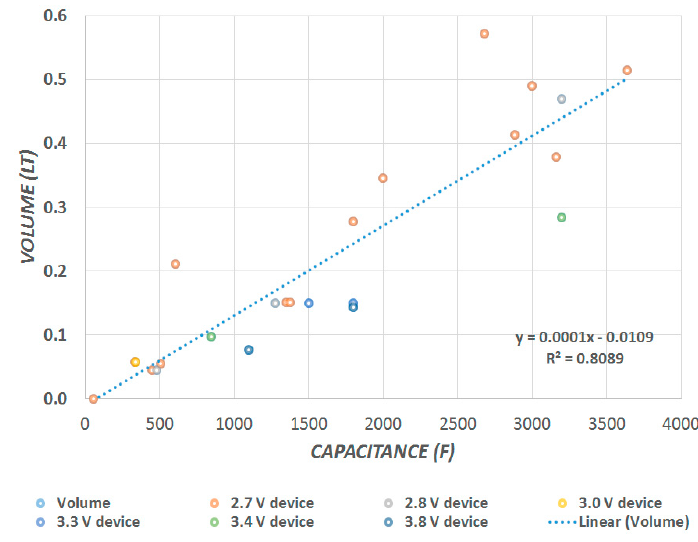
Figure 1. Volume vs. capacitance, exhibiting linear characteristics. Table 1. Commercially available supercapacitor (SC) properties.